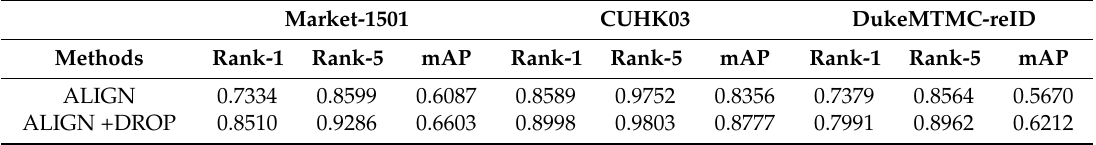
Table 7. Performance of ALIGN and ALIGN +DROP methods on part missing